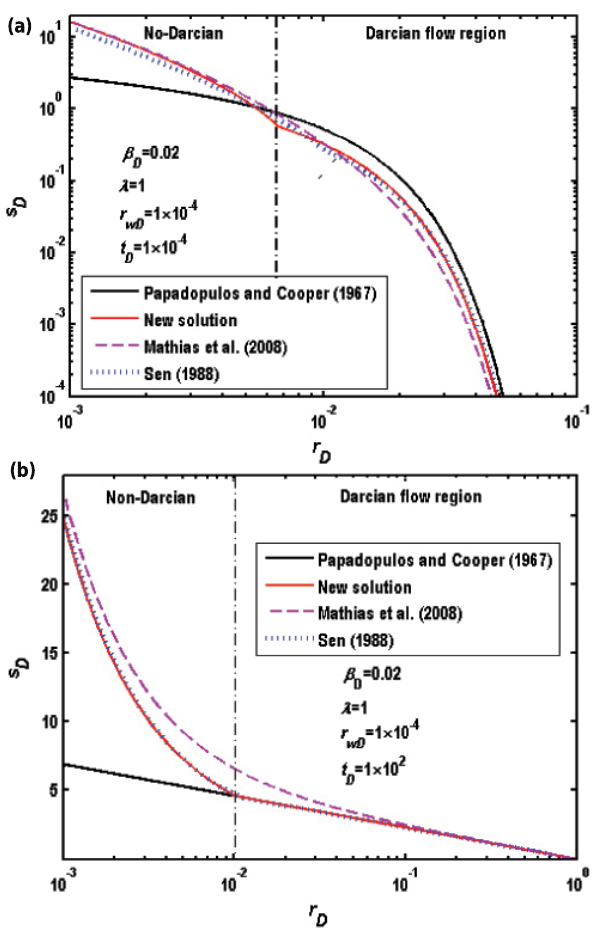
Figure 4. (a) Comparison of the distance drawdowns by the fully Darcian flow model (Papadopoulos and Cooper, 1967), the fully non-Darcian flow model (Mathias et al., 2008), the two-region flow model (Sen, 1988), and the new model in early pumping stage. (b) Comparison of the distance drawdowns by the fully Darcian flow model (Papadopoulos and Cooper, 1967), the fully non-Darcian flow model (Mathias et al., 2008), the two-region flow model (Sen, 1988), and the new model in late pumping stage.